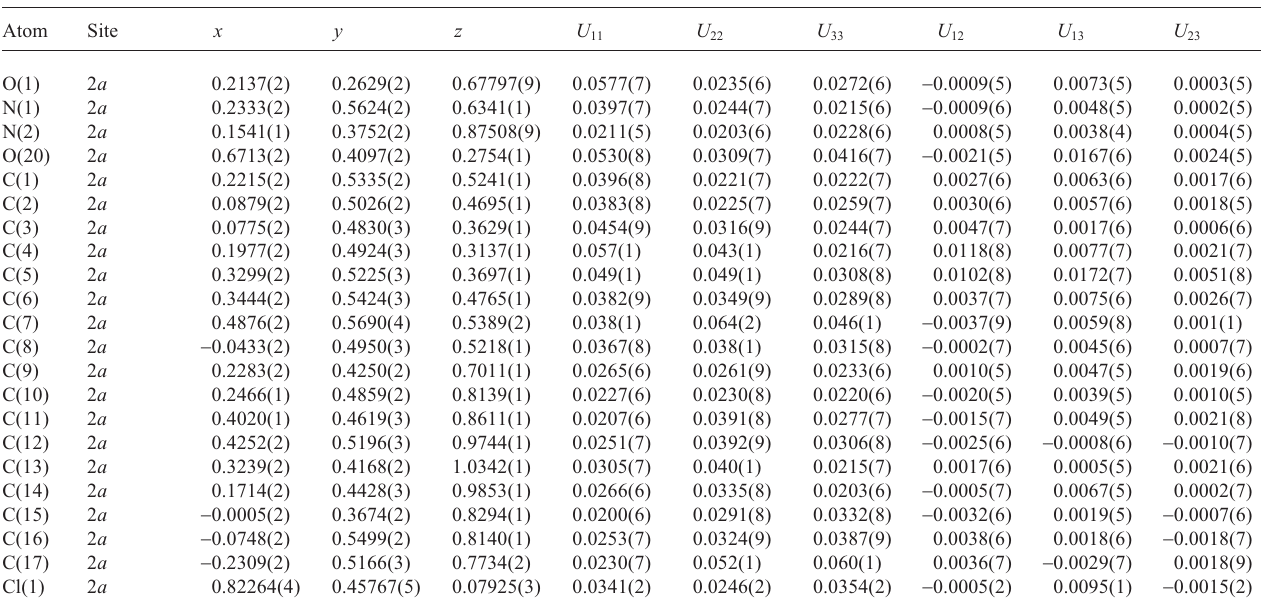
Table 3. Atomic coordinates and displacement parameters (in Å 2 )